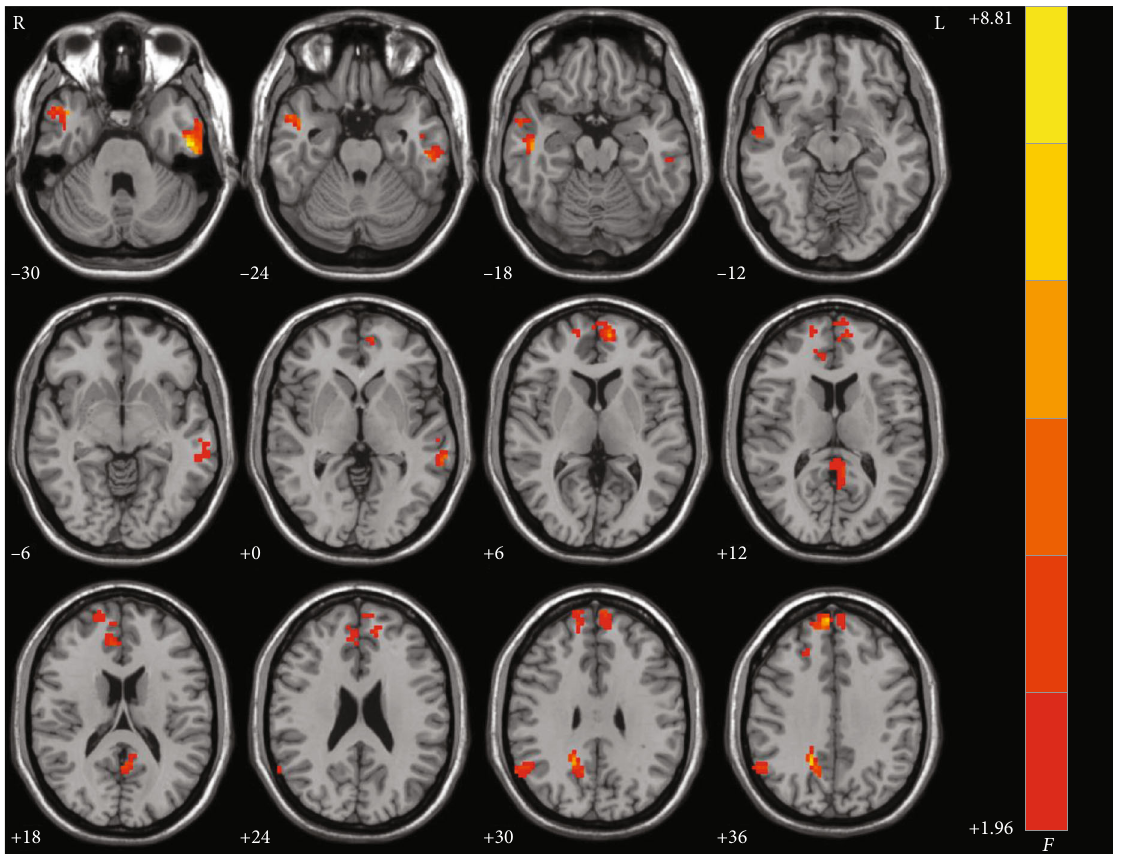
Figure 1: Brain regions within the DMN showing group di ff erences of NH values among three groups. Color bar indicates F values from ANCOVA (age, years of education, and framewise displacement as covariates). NH: network homogeneity; DMN: default mode network; ANCOVA: analysis of